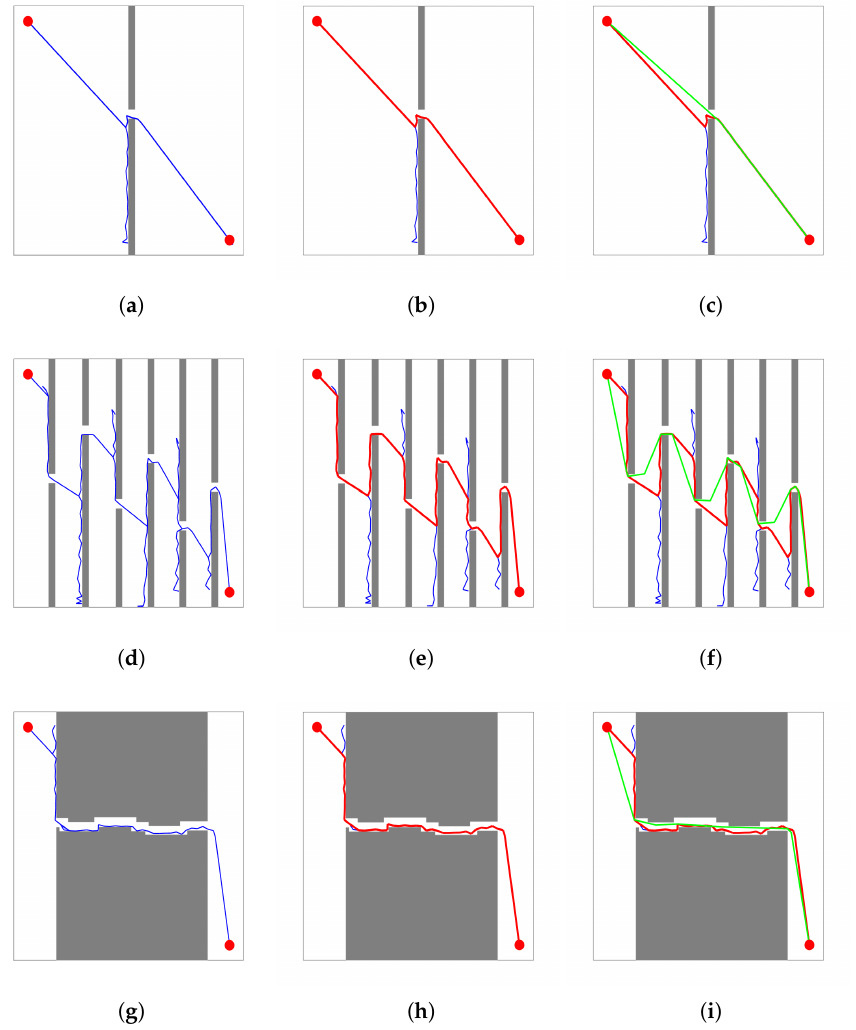
Figure 9. Planning results of BS-RRT and cyclic pruning algorithms in the three maps. The blue line refers to the path of the BS-RRT algorithm, the red line represents the backtracking path after BS-RRT connects the starting point and the end point, and the green line corresponds to the final path after cyclic pruning. ( a , d , g ) show the running results of BS-RRT algorithm in three maps; ( b , e , h ) show the backtracking path of BS-RRT algorithm in three maps; ( c , f , i ) show the final path generated after pruning in three maps. Table 2. Comparison of path changes before and after pruning with cyclic pruning algorithms. Figure Before Pruning